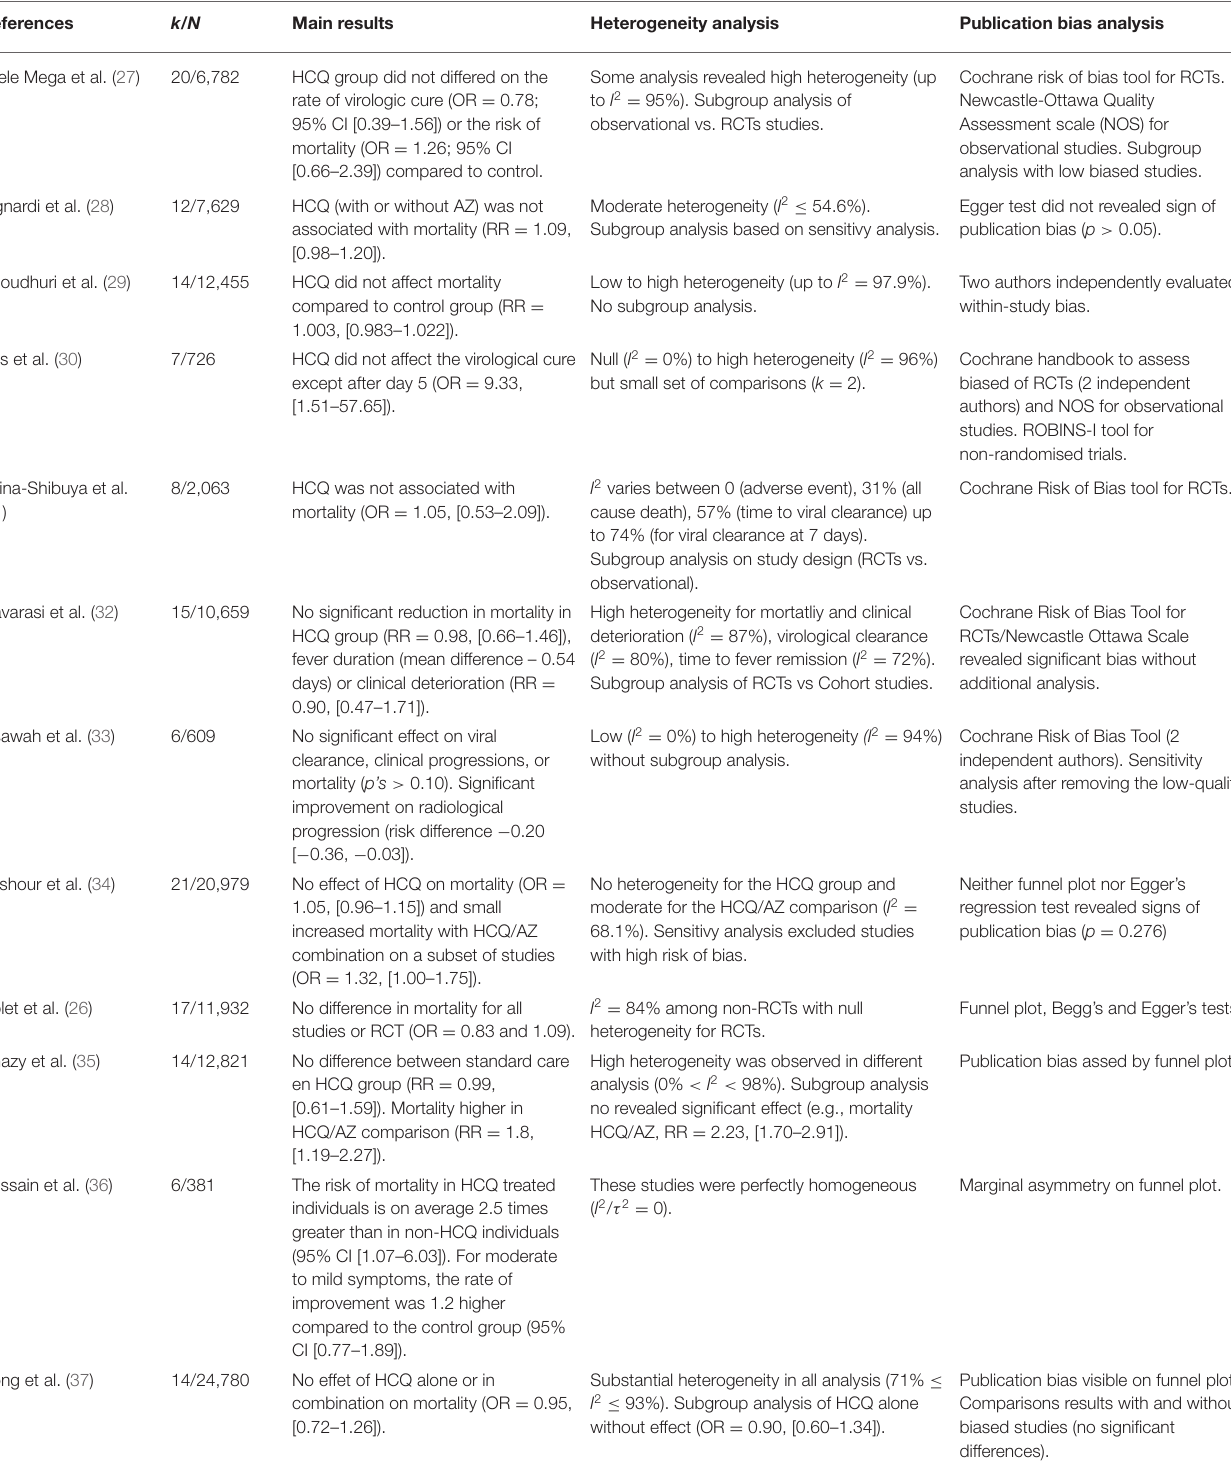
TABLE 2 | Meta-analysis on the efficacy of hydroxychloroquine on COVID-19 patients published in peer-reviewed